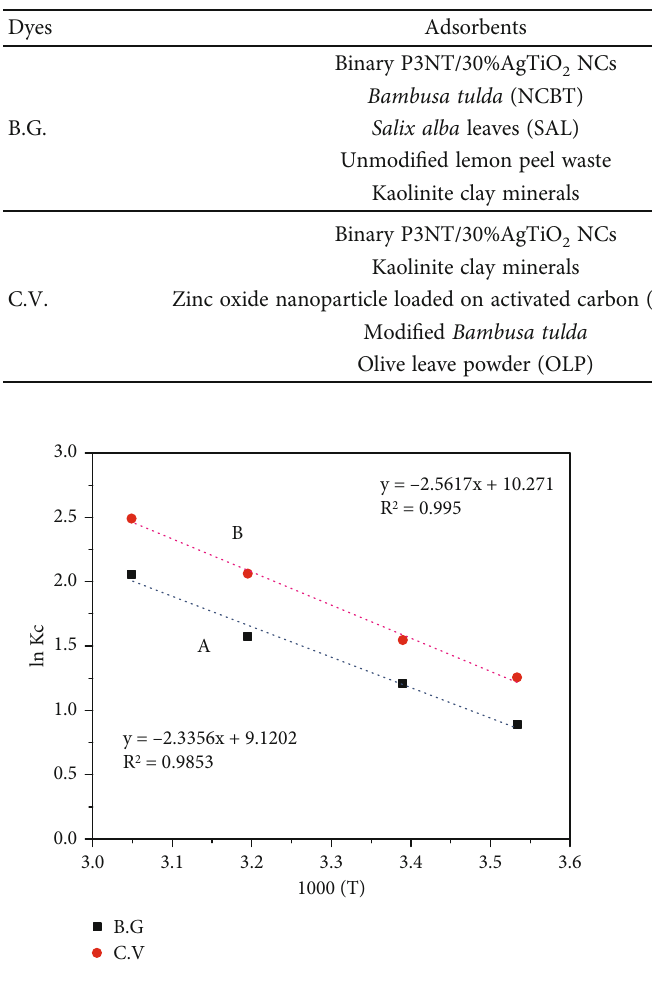
’ sorption from Figure 17: Graph of ln K C of B.G. and C.V. dyes Figure 18: The removal e ffi ciency of B.G. and C.V. dyes from NCs versus aqueous solutions to the binary P3NT/30%AgTiO 2 multiple real samples of the binary P3NT/30%AgTiO 1000/ T . phase (experimental environment: 50mL solution, B.G. concentration of 5mg · L − 1 , pH = 6 , and 25mg of binary P3NT/ 30%AgTiO NCs for B.G. dye and 50mL solution, pH = 8 , C.V. 2 concentration of 5mg · L − 1 , and 25mg of the P3NT/30%AgTiO for C.V. dye and stirring time = 90 min and temperature = 295K